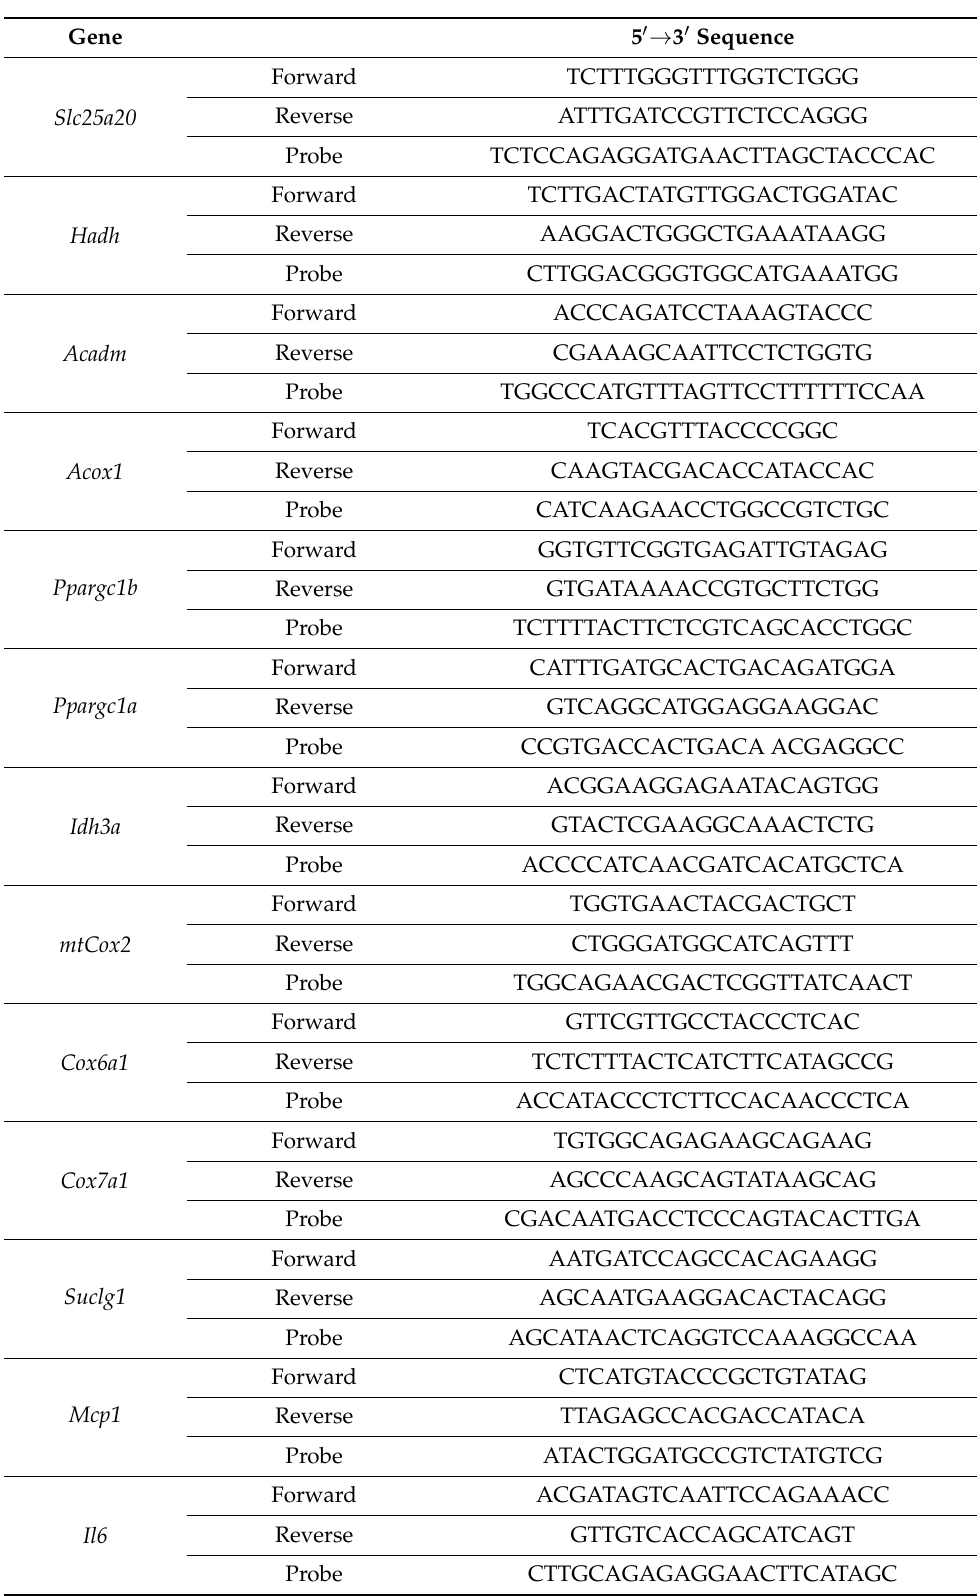
Table 1. Cont. Gene 5 (cid:48) → 3 (cid:48)